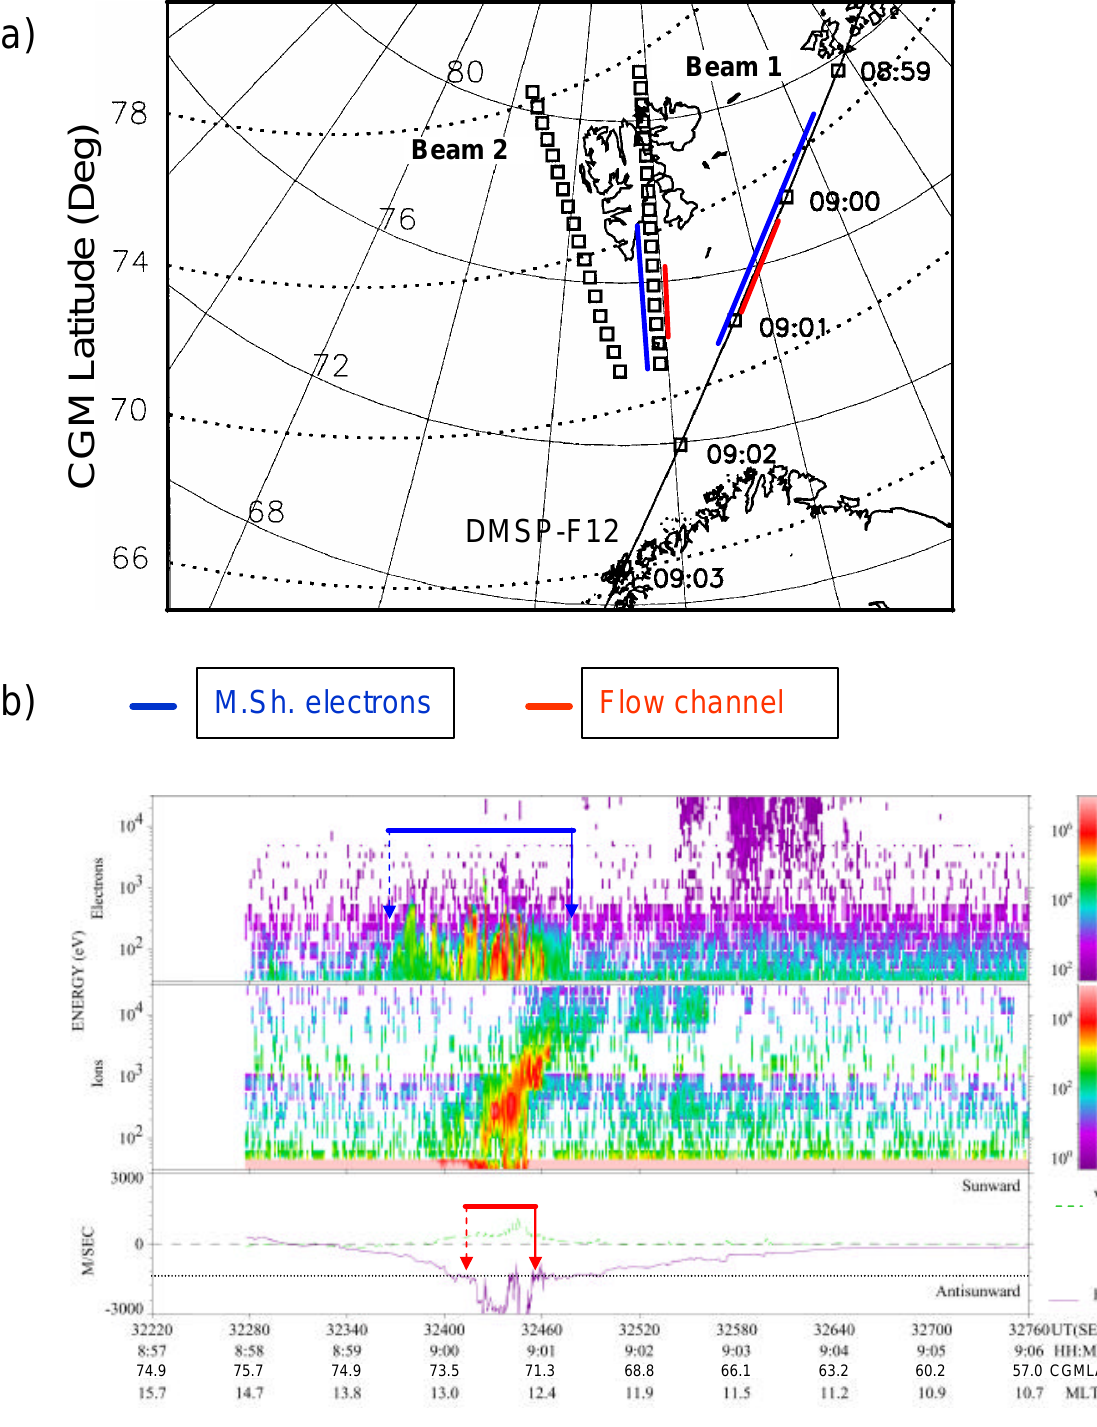
Fig. 5. Similar presentation as in Fig. 3 but for the DMSP F12 pass at around 09:00UT.